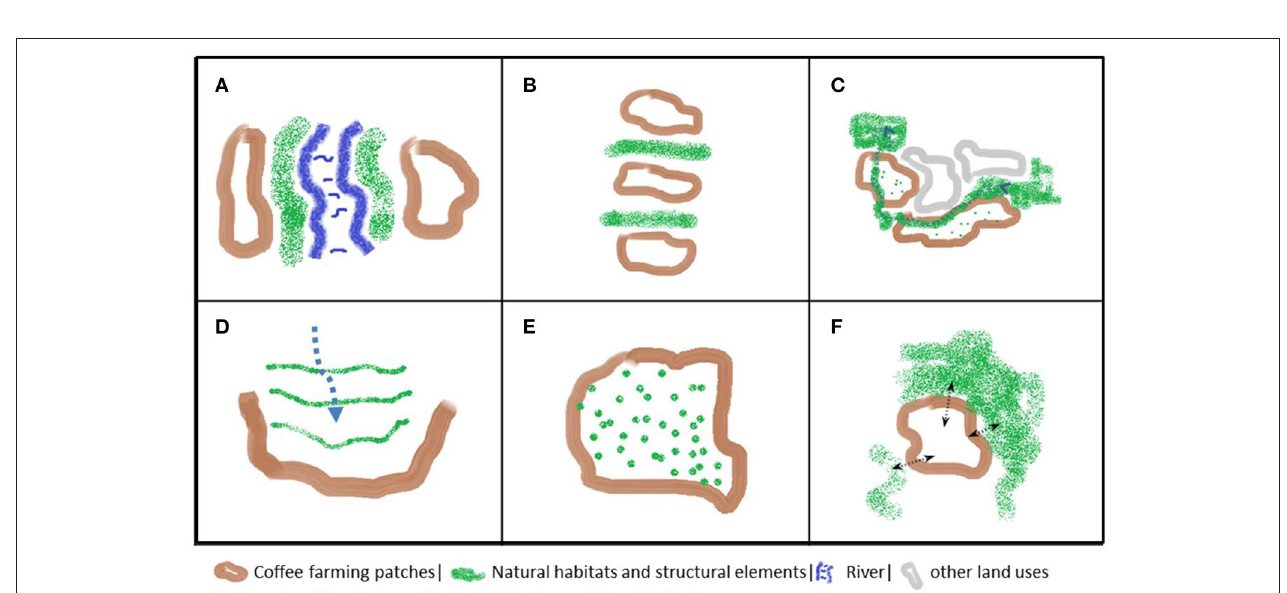
FIGURE 2 | Multiscale benefits offered by implementation of climate-smart coffee practices. Farm-level benefits are summarized in view of the overall goal of the implementation of the climate-smart coffee practice on field. Own elaboration.